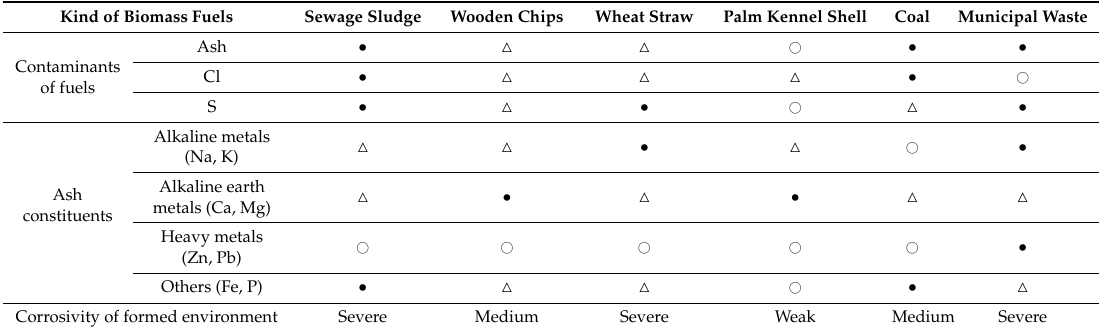
Table 2. Impurities that influence corrosion damage and corrosivity of boiler combustion gas environment in typical biomass fuels